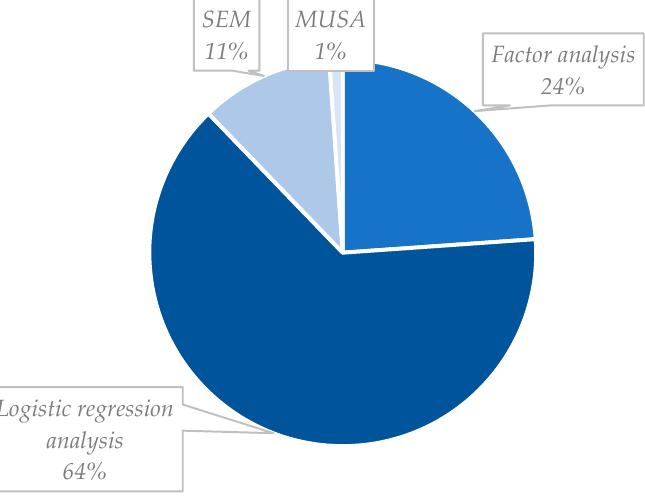
Figure 8. Analysis of methods utilized in the literature.